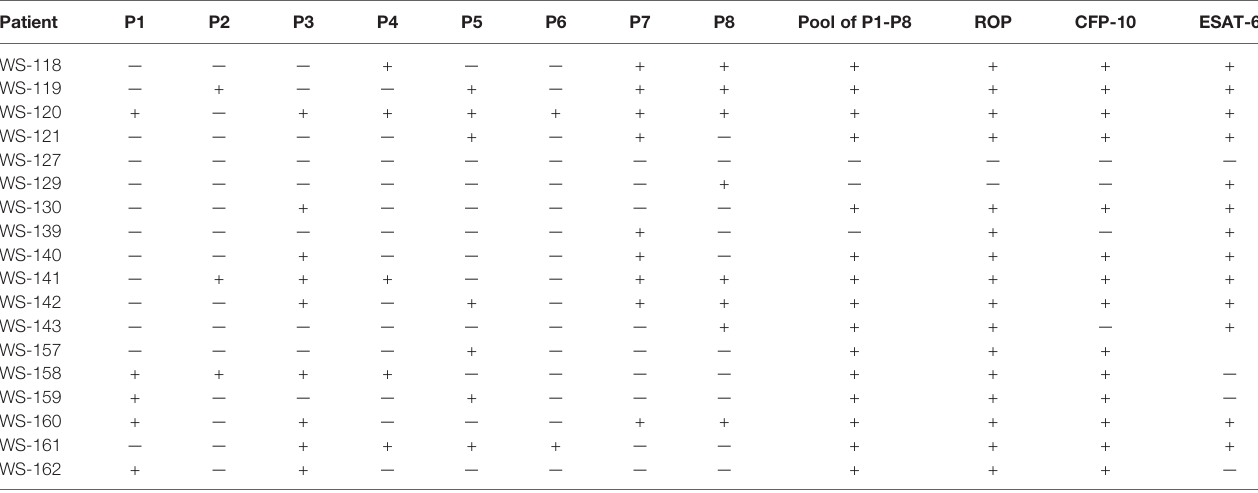
TABLE 4 | ELISPOT responses of the 18 Mtb patients to various forms of TB antigens. Patient